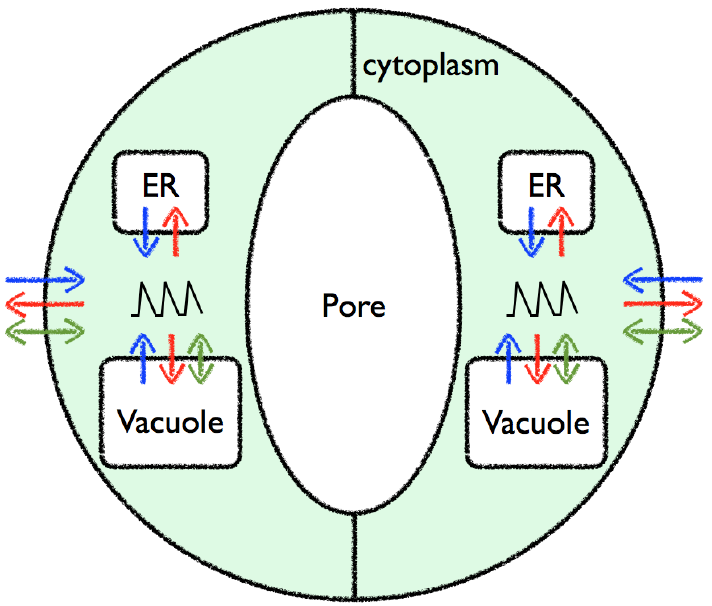
Figure 5. Sketch of a stomate showing a pair of guard cells containing the vacuole and the ER. Channels/pumps are indicated by the lines, with the arrows showing the ion transport direction. Exchangers are drawn with double